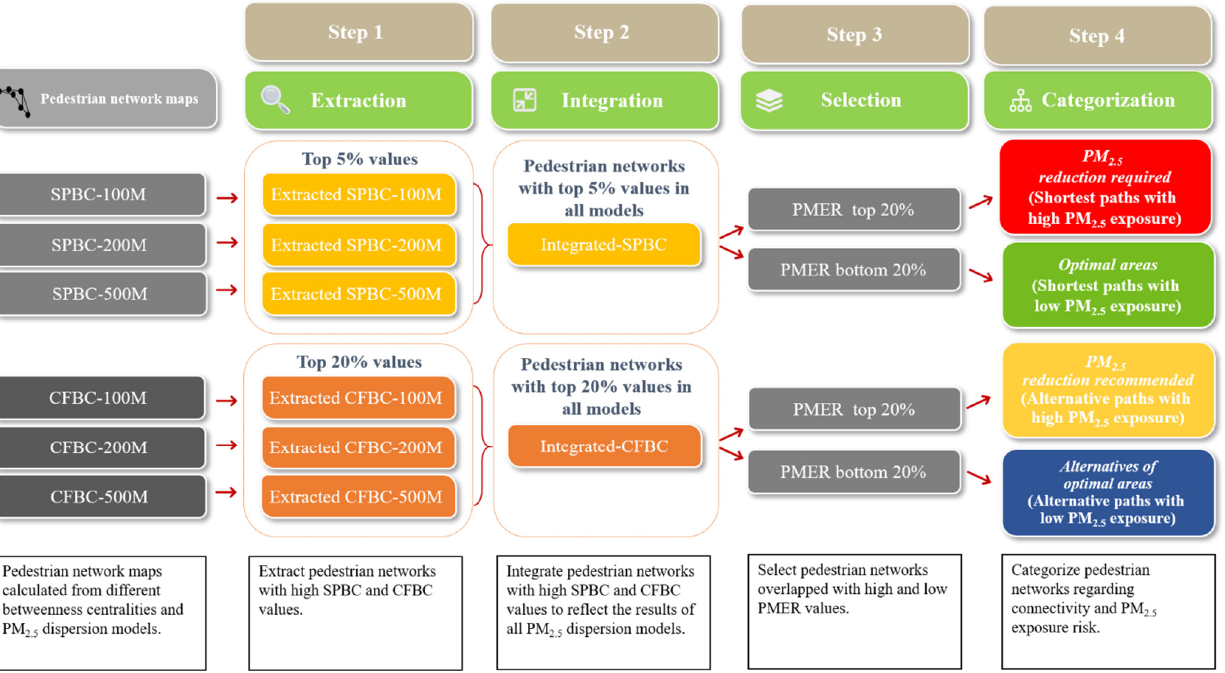
Figure 2. The categorization process of pedestrian networks in the study area.